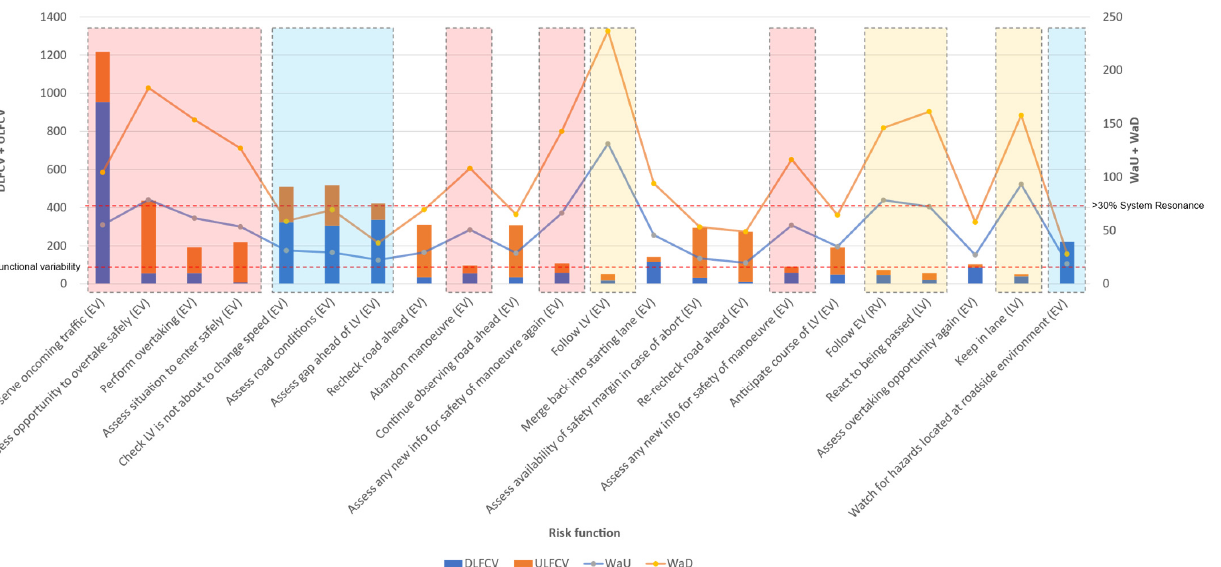
Figure 11. Risk functions for human drivers composed of functional variability and system reso- nance.